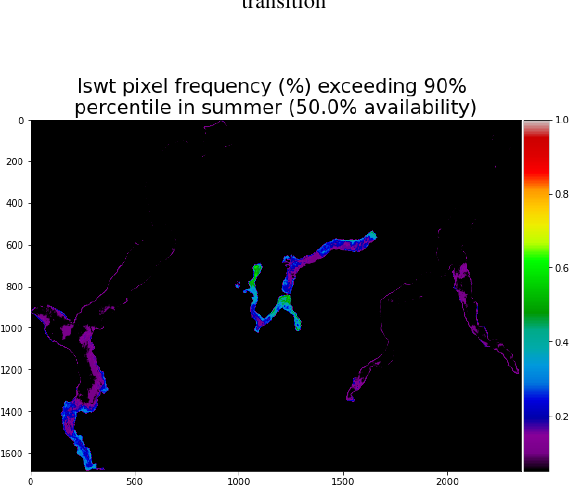
Figure 20. LSWT - spatial pattern map in spring - summer transition